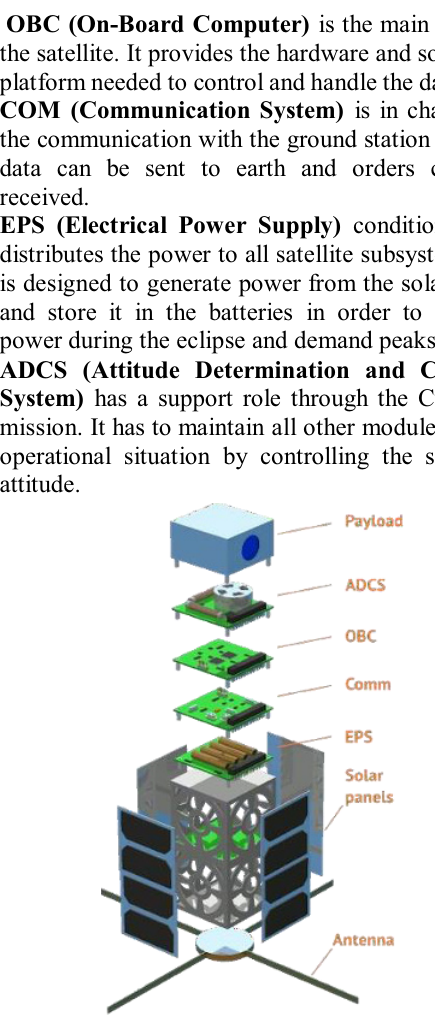
Fig. 1. Example of a CubeSat architecture.